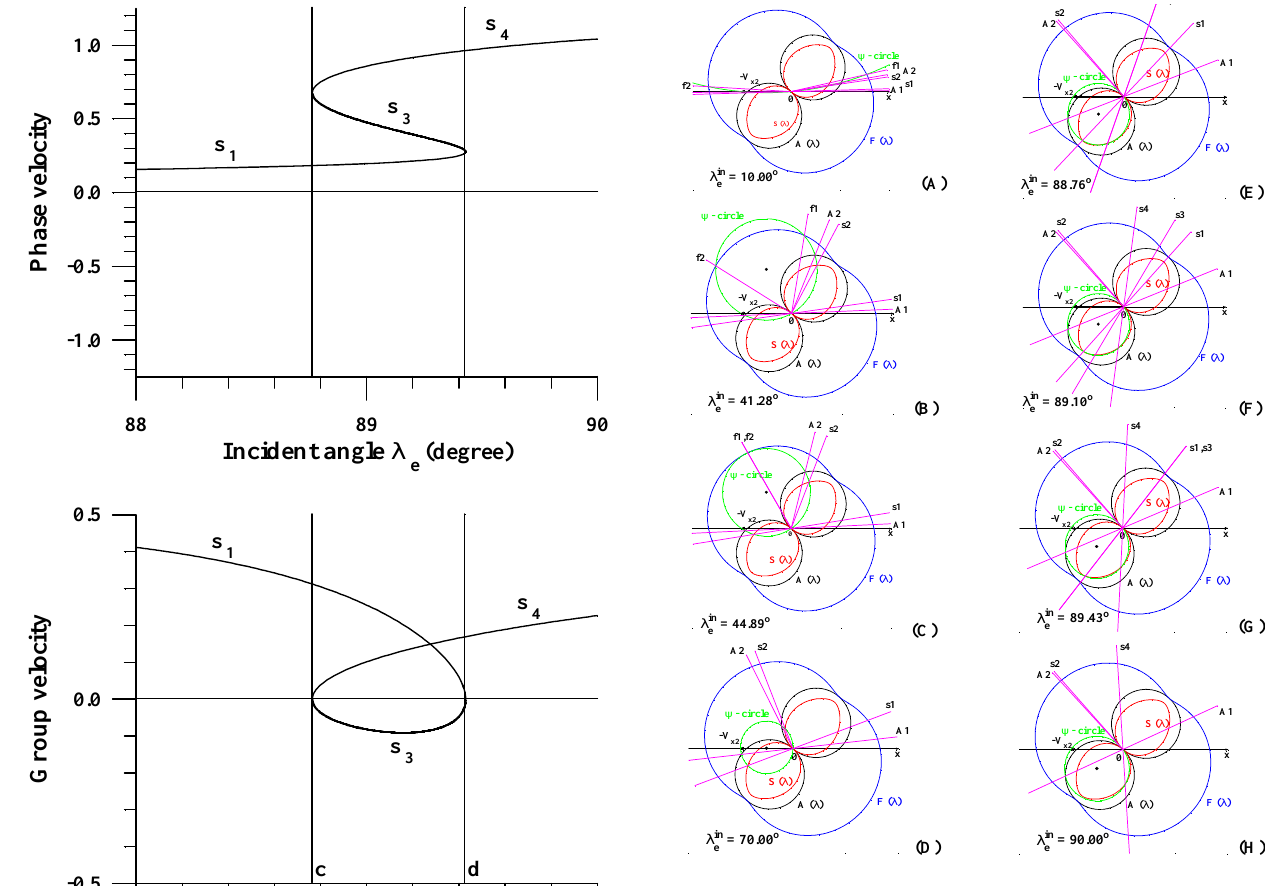
Fig. 10. Graphic analysis of refraction of MHD waves on a shock wave. The polar angles of the cross points of the 9 -circle and phase diagrams for the fast ( F) , slow ( S) magnetoacoustic and Alfv´en ( A) waves (the corresponding polar lines are shown on the plots) determine the propagation angles of the waves. Denotations are the same as in Figures 1, 6 and 8. The centre of the ψ -circle is denoted by the symbol “ • ” (not shown on the plot A)